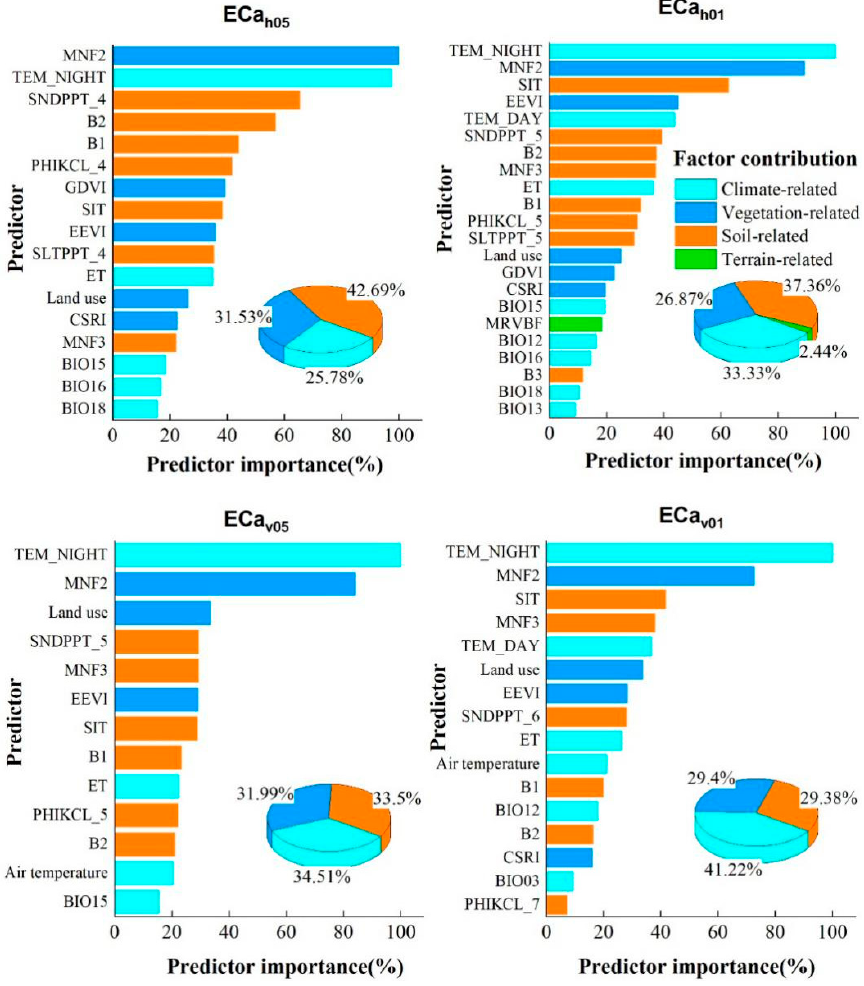
Figure 3. Relative importance of covariates for ECa prediction per electromagnetic induction (EMI) coil configuration using the recursive feature elimination (RFE)-random forests (RF) model. Pie chart clarifies the contribution of various environmental factors related to climate, soil, vegetation and terrain.